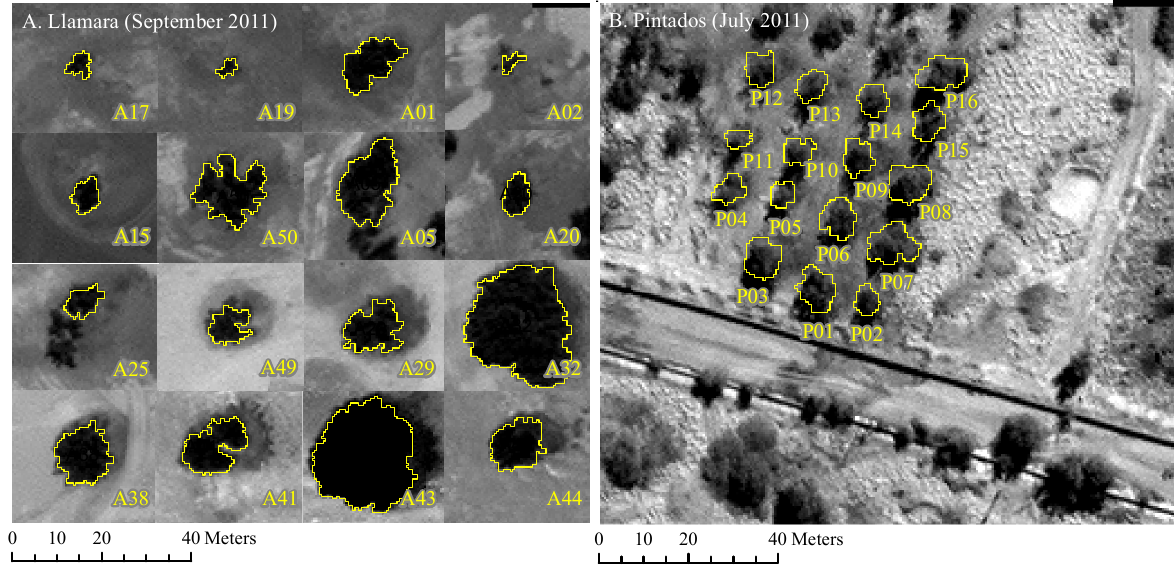
and DLLAI of single pics green